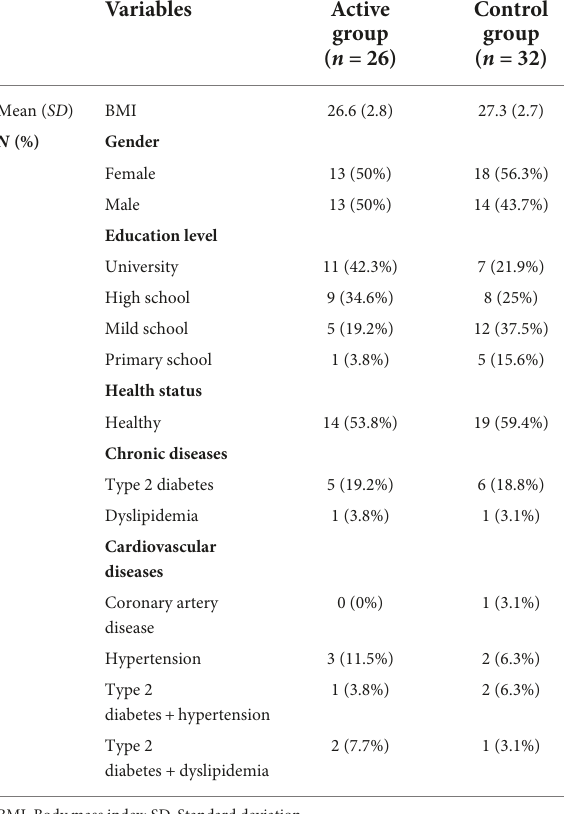
TABLE 2 Demographic baseline characteristics of the